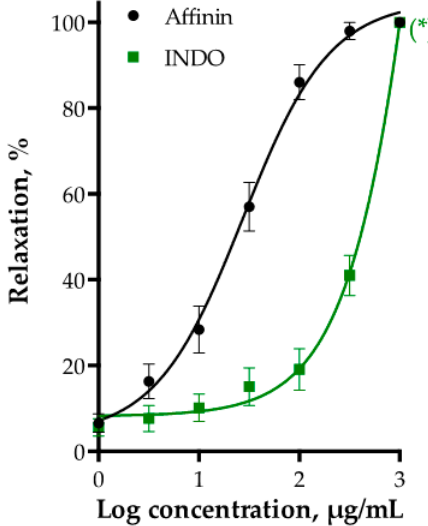
Figure 5. Vasodilatory effect of affinin in the absence (control) and presence of indomethacin (INDO, 10 µM) in rat aortic rings. Values are expressed as mean ± SEM ( n = 6); * p < 0.001.